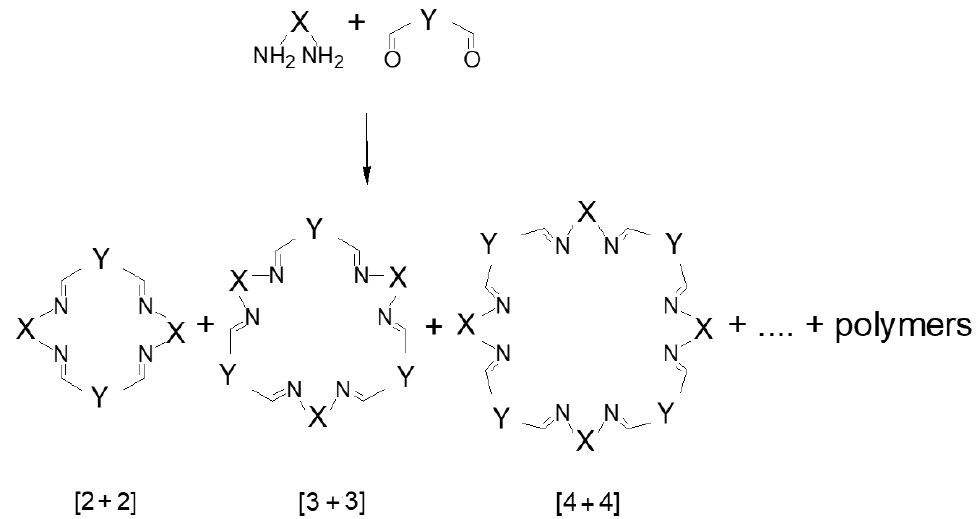
Figure 1. Some of the potential products of the [n + n] condensation of diamines and dialdehydes.